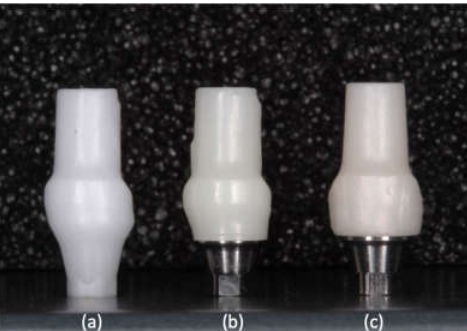
Figure 2. Titanium prototype abutment (NobelReplace Abutment Conical Connection RP 3 mm).